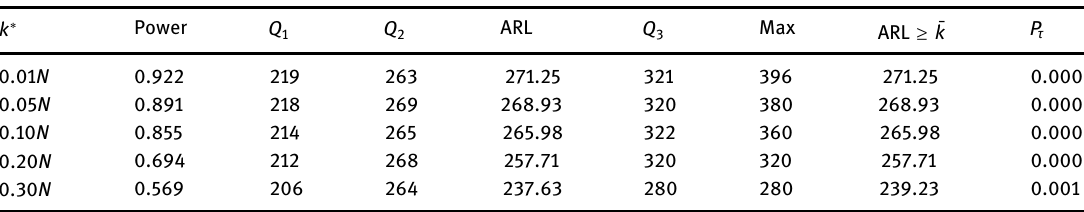
Table 2: Conditional powers, average of run lengths and probability of false alarms for score test with ( ) ≡ g s c under H